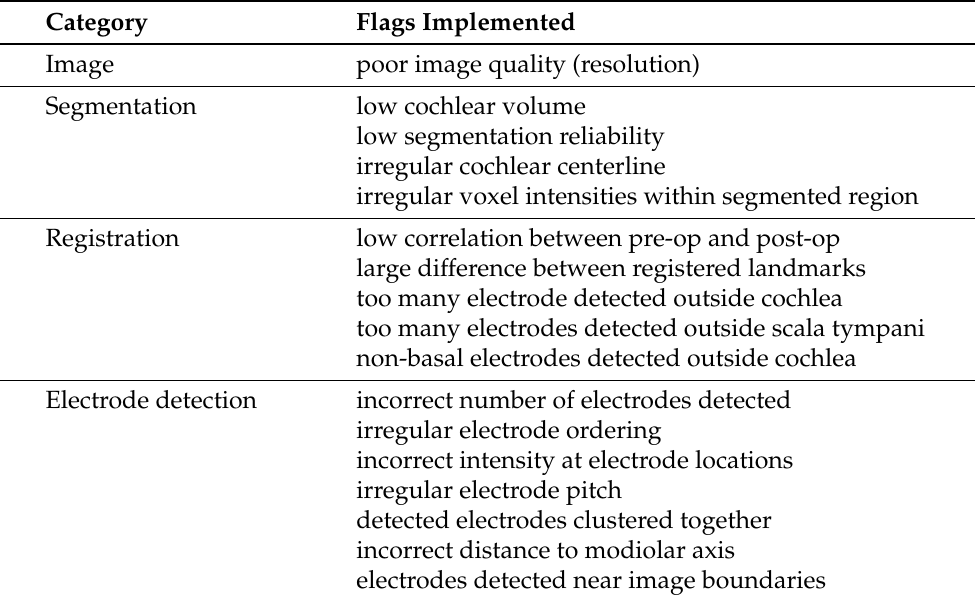
Table 1. Description of different flags from the self-check module as implemented in Nautilus. The failure flags trigger a decreased level of confidence in the processed results when extra attention is